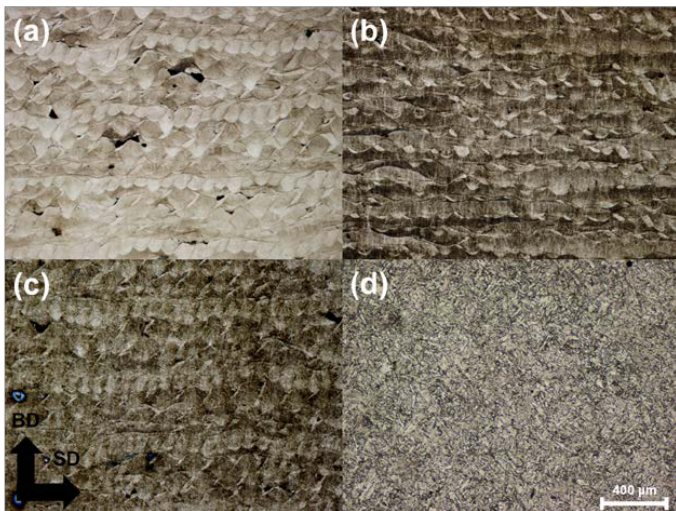
Figure 4. Optical microscope (OM) images of maraging steel samples ( × 50): ( a ) as-built condition; ( b ) after 6 h aging at 450 ◦ C without ST; ( c ) after 750 ◦ C ST for 2 h and aging at 450 ◦ C for 6 h; and ( d ) after 850 ◦ C ST for 2 h and aging at 500 ◦ C for 6